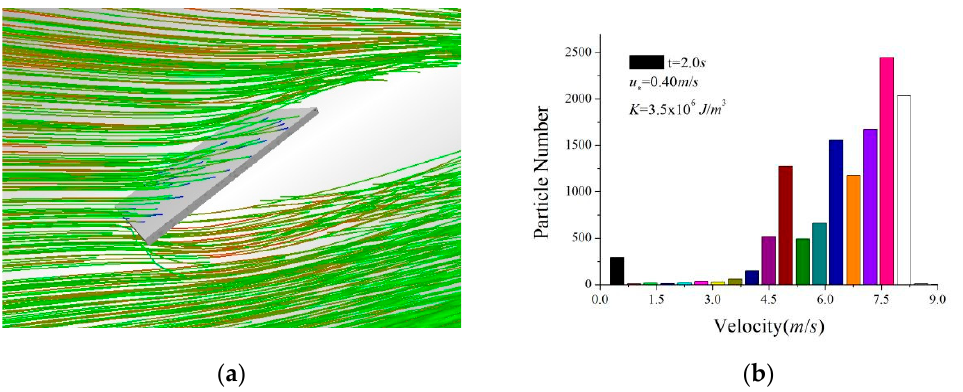
Figure 11. Movement of dust particles with a particle size of 100 µ m around solar panels when u ∗ = 0.40 m/s and K = 1.05 × 10 6 Jm − 3 . ( a ) Particle streamlines. ( b ) Velocity distribution of particles at 2.0 s.